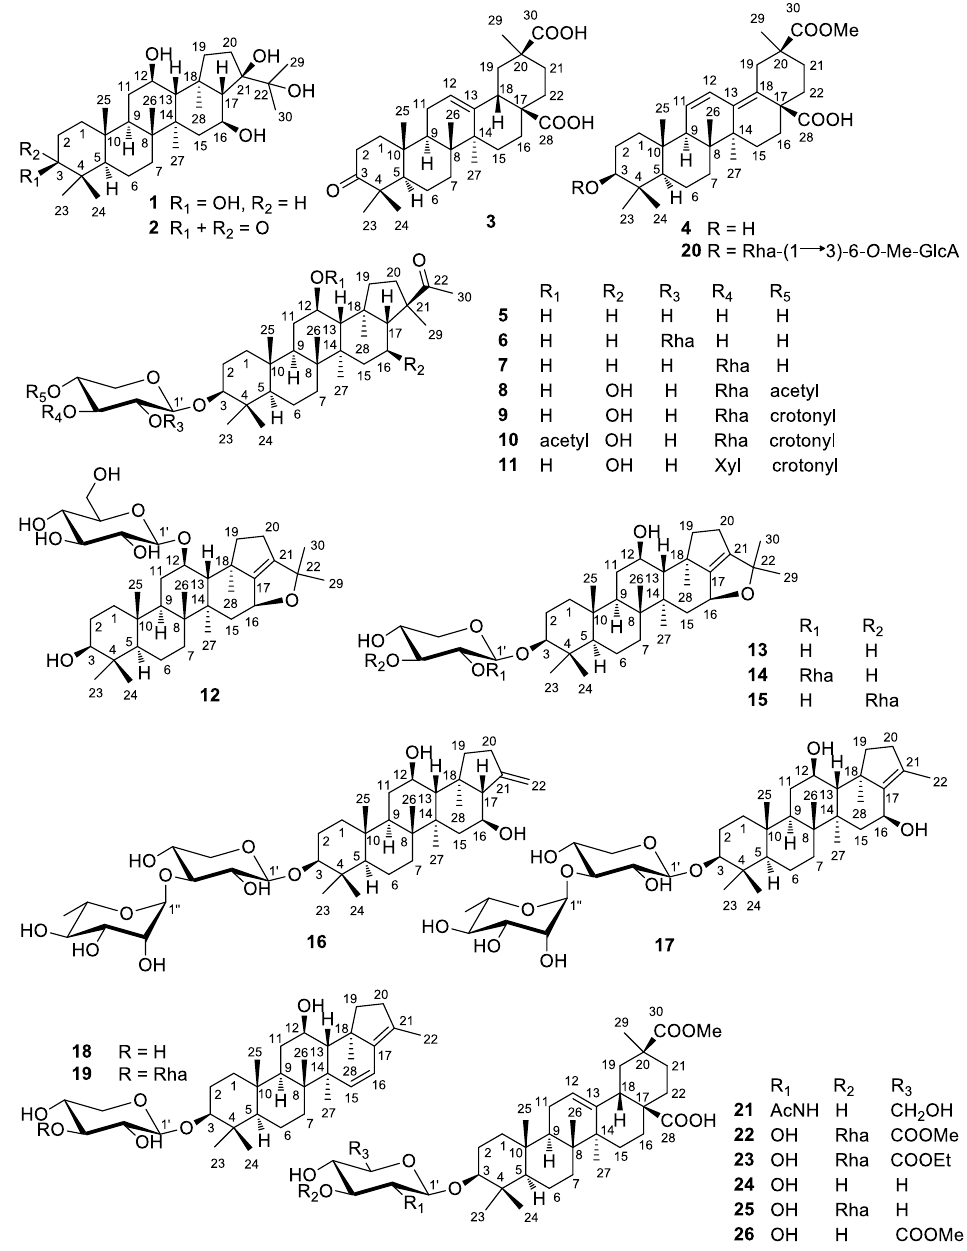
Figure 1. Chemical structures of compounds 1 – 26 from Glinus oppositifolius.